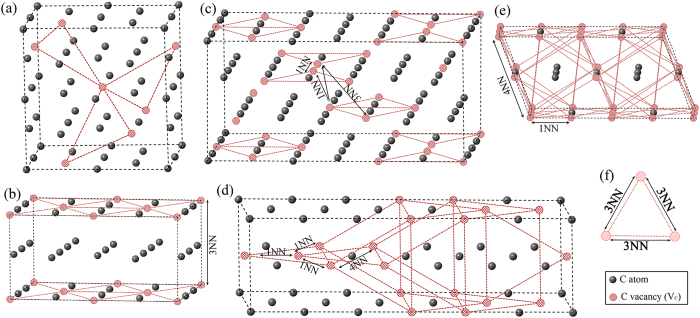
Vacancy configurations in C-sublattice of (a) Zr8C7 (P4332), (b) Zr6C5 (C2/m), (c) Zr4C3 (C2/m), (d) Zr3C2 (Fddd) and (e) Zr2C (Fd-3m), with significant character of (f) 3NN VC triplet.